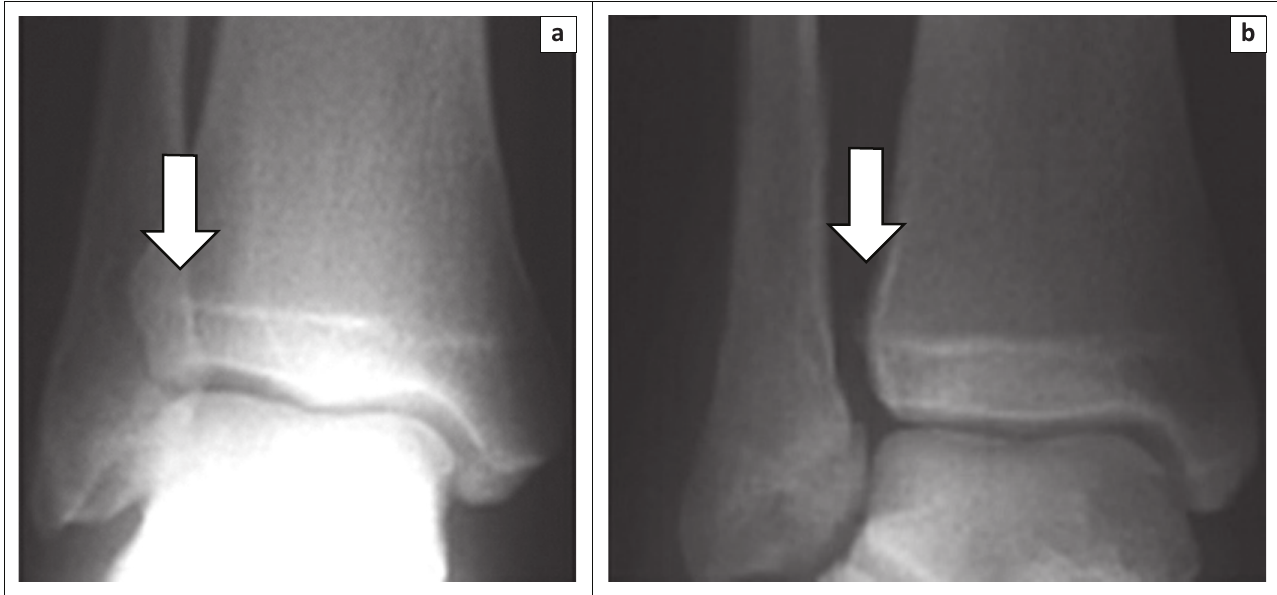
FIGURE 3: X-ray of a (a) normal ankle and (b) an injured ankle with a distal fibular fracture presenting with no tibiofibular overlap and an increased tibiofibular clear space. TABLE 1: Syndesmotic injury imaging criteria. Radiographic finding